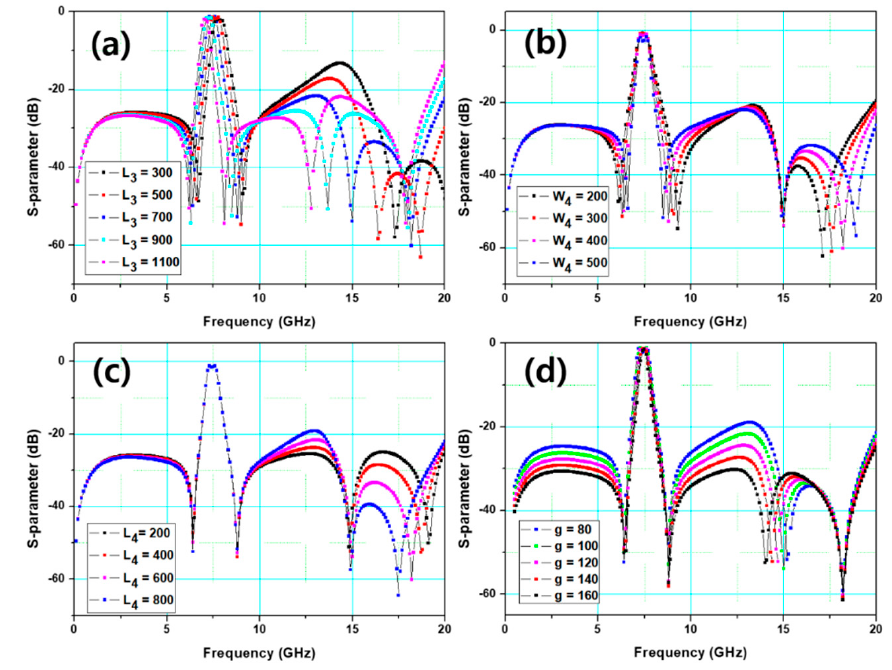
Figure 5. Simulated results of the proposed dual-mode BPF for different ( a ) L 3 , ( b ) W 4 , ( c ) L 4 , and ( d ) g parameters.